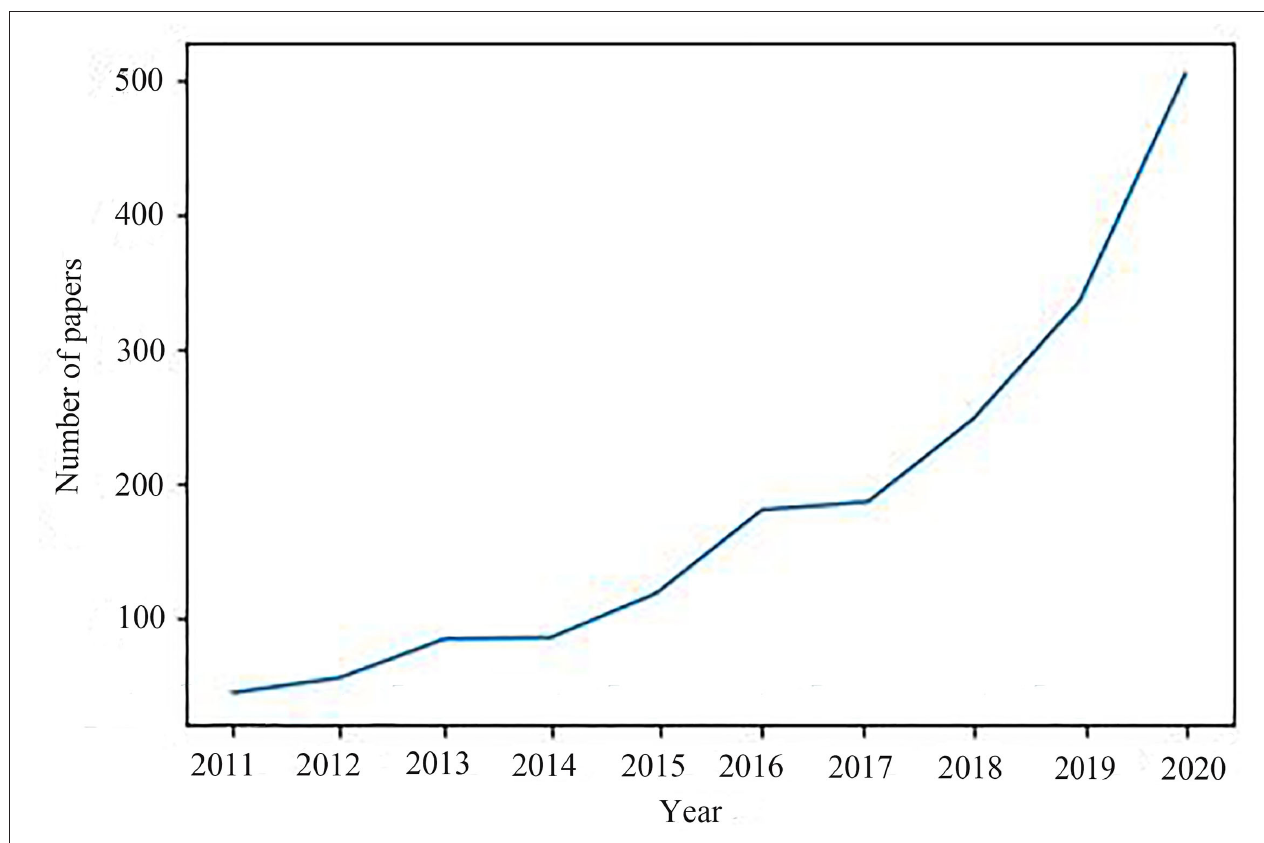
FIGURE 1 | Number of articles in